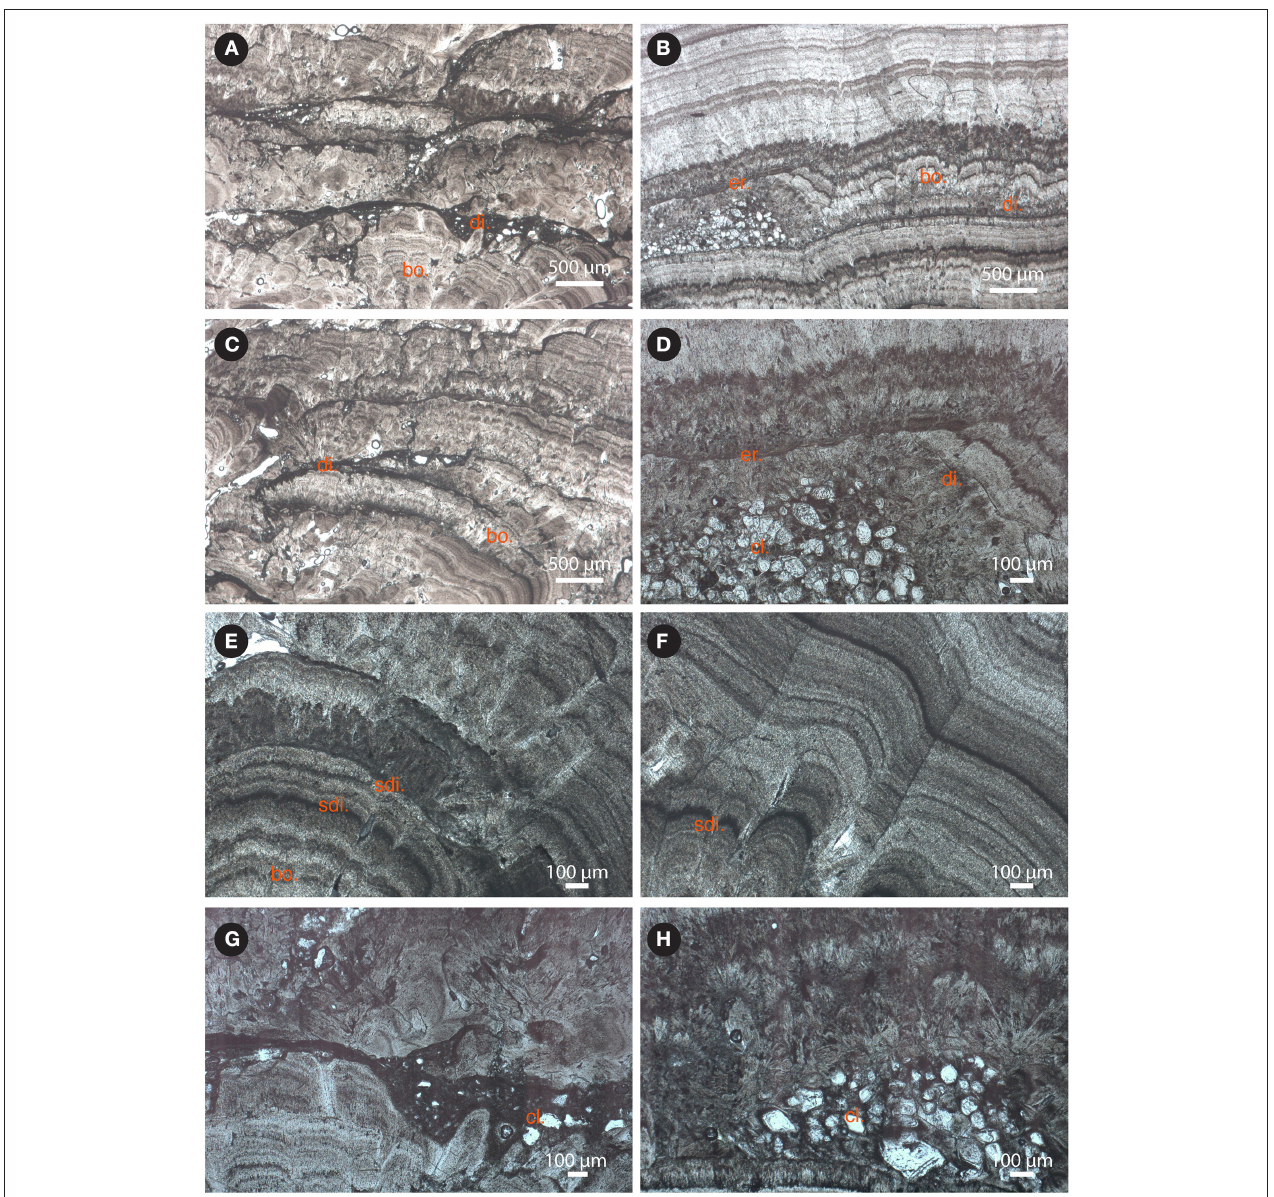
FIGURE 4 | Close-up views of cement layers by the BOS2-1A, BOS2-1B, BOS3, and STB3 samples (see Figure 3 for larger views; di., dissolution structures; sdi., slight dissolution structures; bo., botryoid; er., erosion surface; cl., clastic sediments): (A) successive layers of acicular calcite cements organized in fans interrupted by erosion and dissolution cavities infilled by clastic sediments (BOS2-1B); (B) alternating dark- and light- colored bands trapping clastic accumulation (BOS3); (C) the cemented layer contacts are dissolved and underlined by fine clastic sediments (BOS2-1A); (D) details of the truncated surface covered by new cemented layers (BOS3); (E) botryoid morphology of the acicular calcite cements (STB3); (F) details of the alternating light-colored and black-colored bands in the same layer interrupted by a slight dissolution phase (STB3); (G) fine clastic (argillaceous) infillings trapped between two different cemented layers (BOS2-1A); (H) coarse clastic accumulation (quartz grains with local overgrowth) trapped between two different cemented layers (BOS2-1B). Scale bar is given in the lower-right corner in each